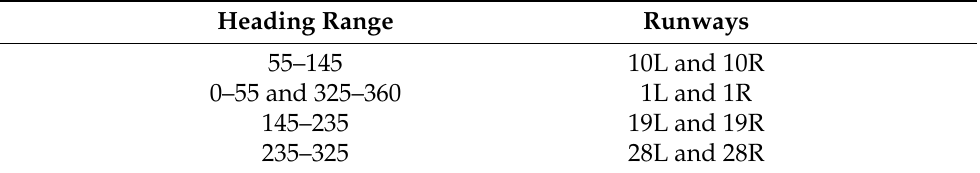
Table 3. Heading range applied to narrow down landing and go-around